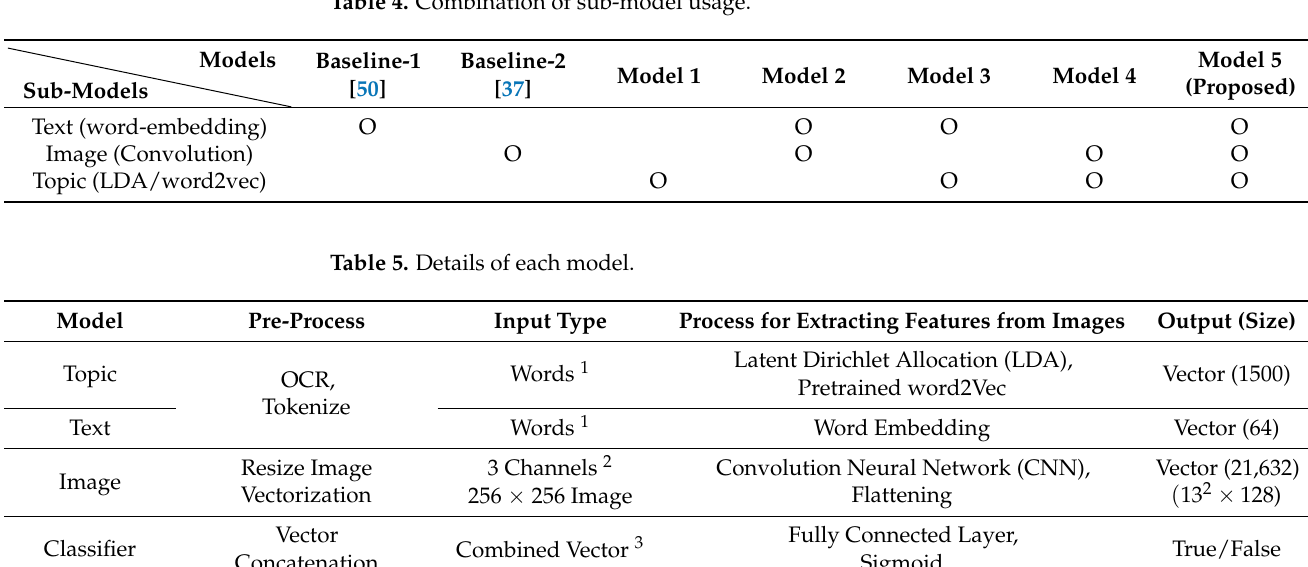
Table 4. Combination of sub-model usage.